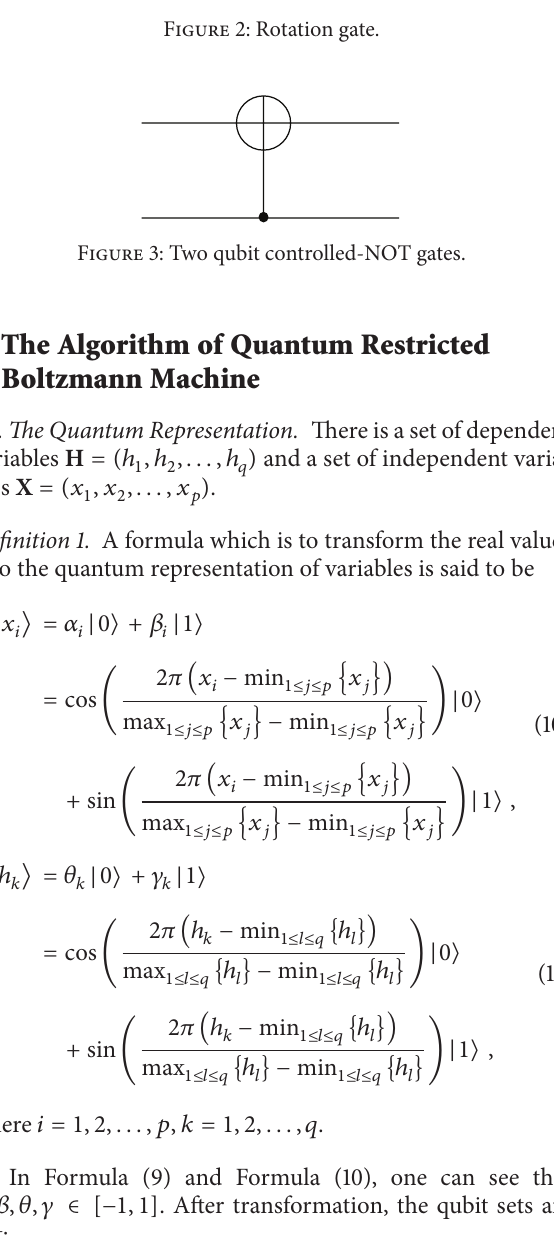
Figure 2: Rotation gate.